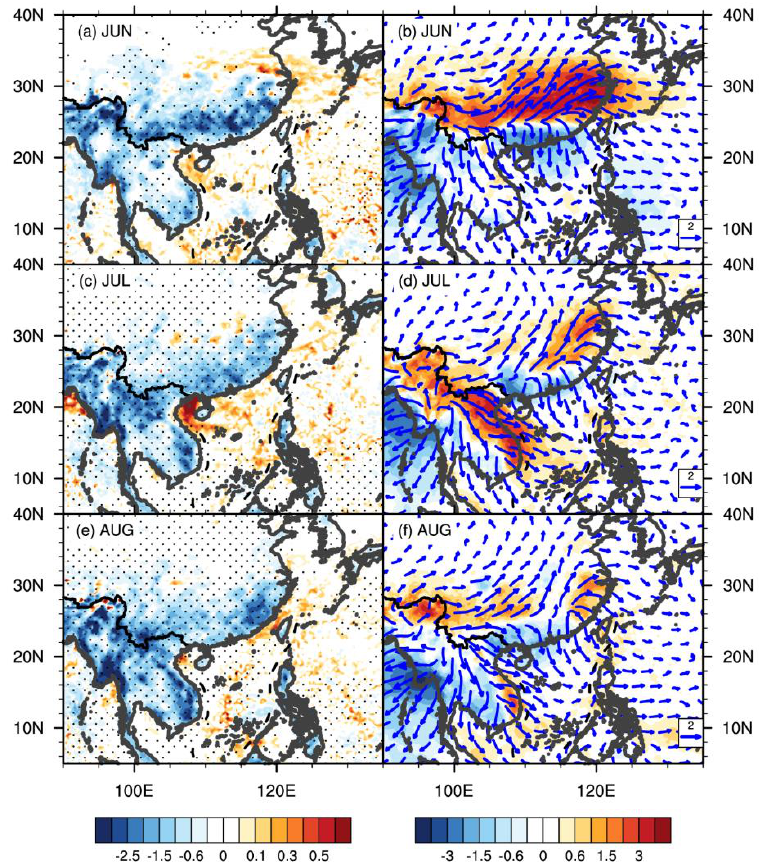
Figure 7. Monthly average differences due to ADE (CTL-SEN test) in precipitation rate (unit: mm/day; dotted area indicate that the values passed the significant test at a level of 90%.) on ( a ) June, ( c ) July, and ( e ) August; and in the vertical integral of moisture flux (vector; unit: kg m −1 s −1 ) and its absolute value (contour; unit: kg m −1 s −1 ) on ( b ) June, ( d ) July, and ( f ) August.